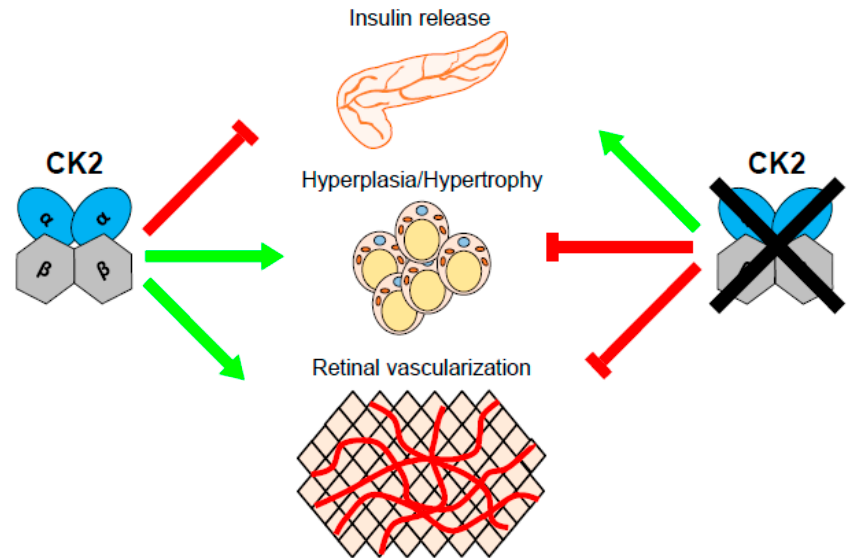
Figure 3. Effect of CK2 on insulin release, adipocyte hyperplasia/hypertrophy, and retinal vascularization. The protein kinase CK2 decreases the insulin release of β -cells. On the other hand, this kinase increases adipocyte hyperplasia/hypertrophy as well as retinal vascularization. Therefore, inhibition of this kinase may represent a promising therapeutic approach for the treatment of T2DM.